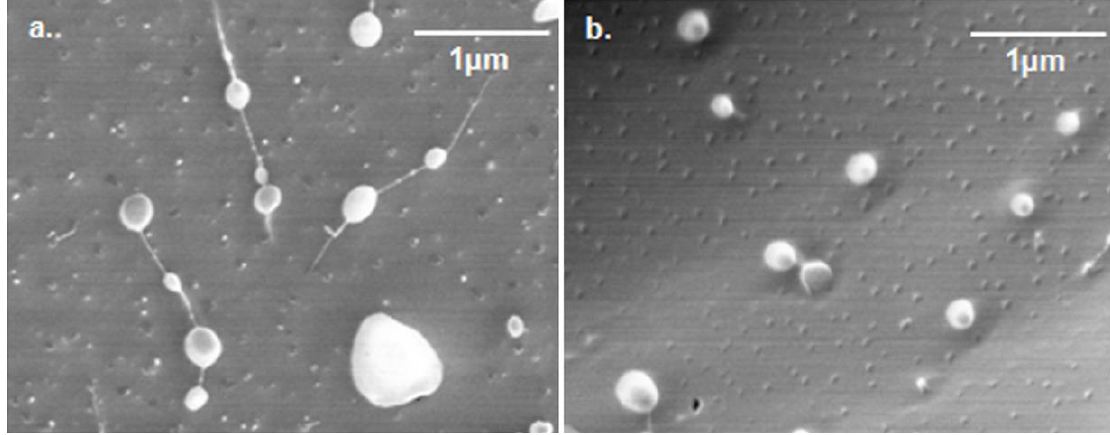
Figure 4. Cryo-FESEM negatively stained micrographs (magnification 30000×) of ( a ) PHC -5.6-1.3 and ( b ) PVC 16 16